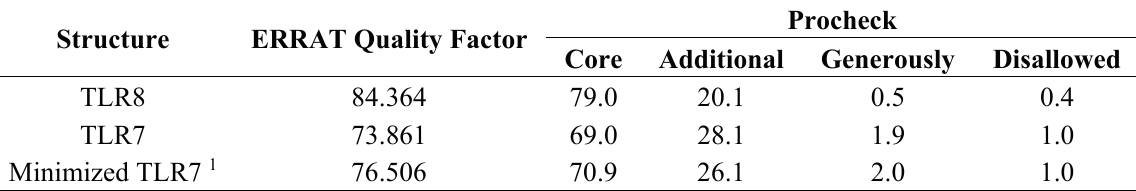
Figure 1. The new model for the Toll-Like Receptor 7 (TLR7) dimer obtained with homology modeling, using the crystallographic structure of TLR8 as template. In both the monomers the respective C-terminals are represented in blue while N-terminals are in red. Table 1. Structural evaluations performed for the Toll-Like Receptor 8 (TLR8) crystallographic structure, the TLR7 model obtained with homology modeling and its minimized